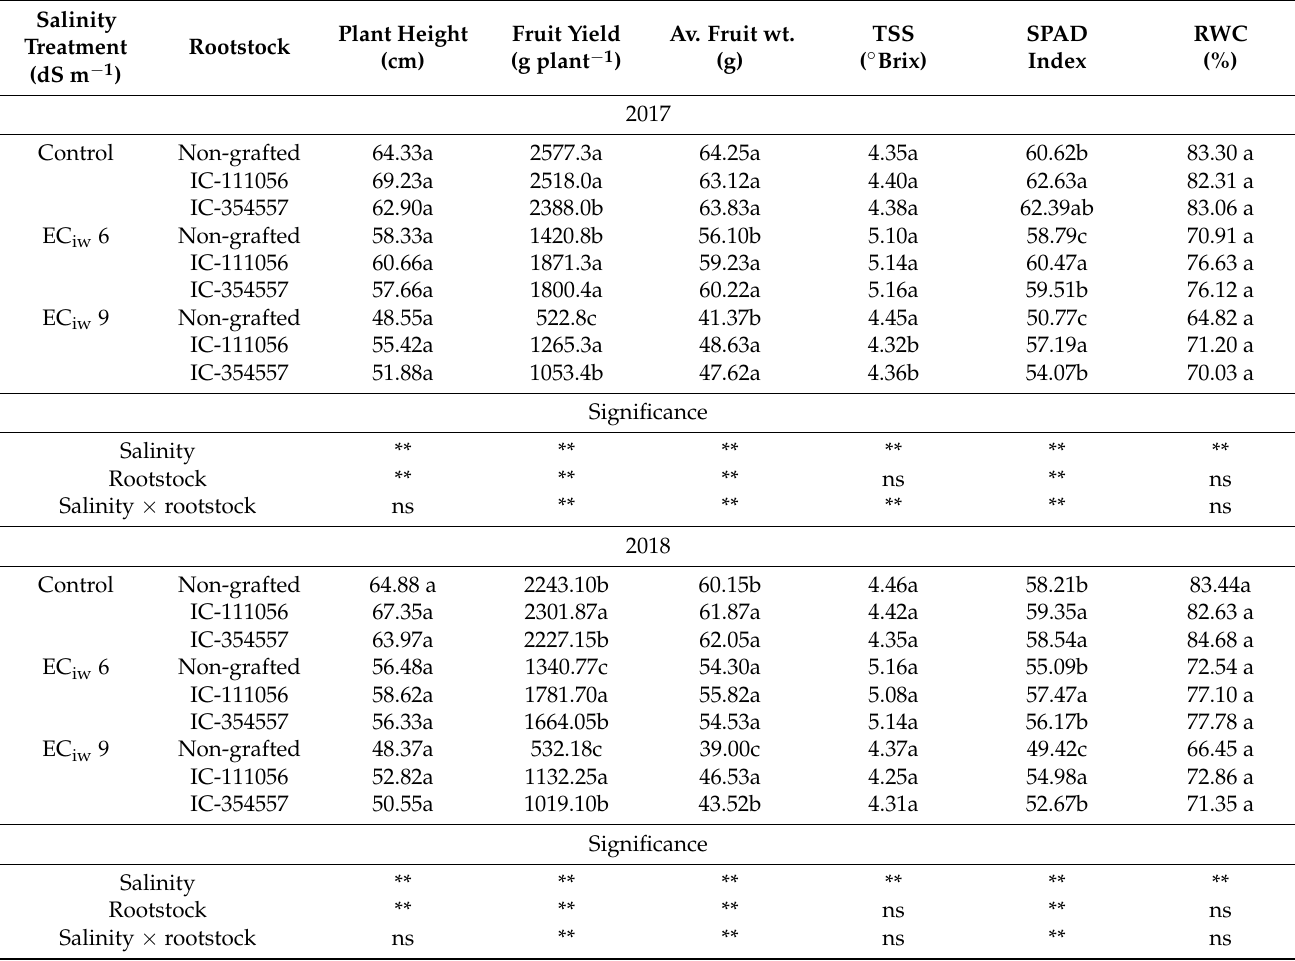
Table 2. Effect of salinity and rootstock combinations on yield components and physiological parameters of tomato (cv. Kashi